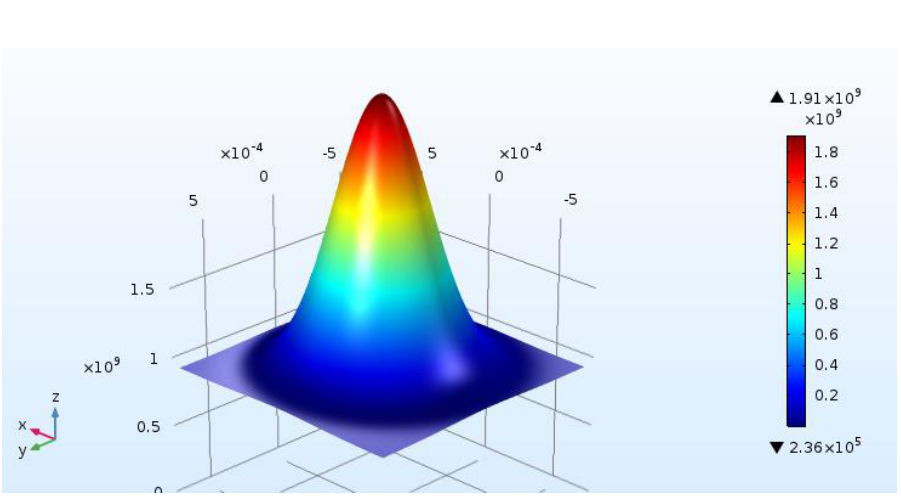
Figure 3. The model of the Gauss heat source.